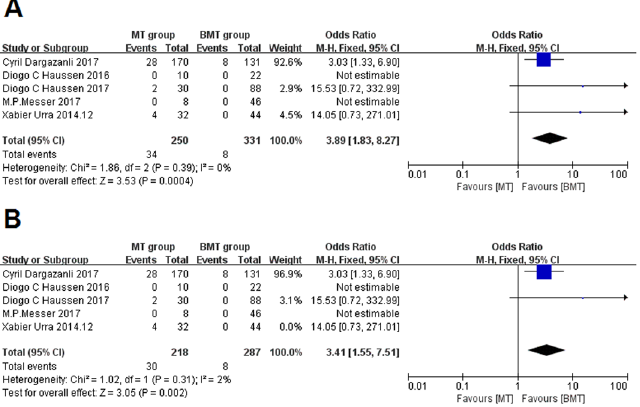
Fig 5. Forest plots of symptomatic intracerebral hemorrhage. A: Forest plots showing the odds ratios of symptomatic intracerebral hemorrhage in the patients treated with MT vs. those treated with BMT. B: Forest plots showing the odds ratios of symptomatic intracerebral hemorrhage between the patients treated with MT and those treated with BMT excluding the study by Urra X et al.